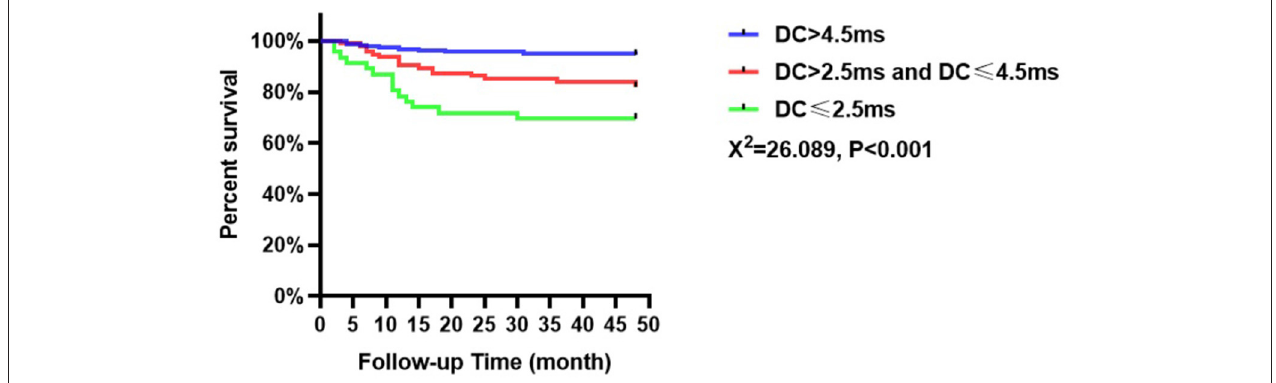
FIGURE 2 | Cumulative survival of MACEs in patients with ACS based on the DC value.